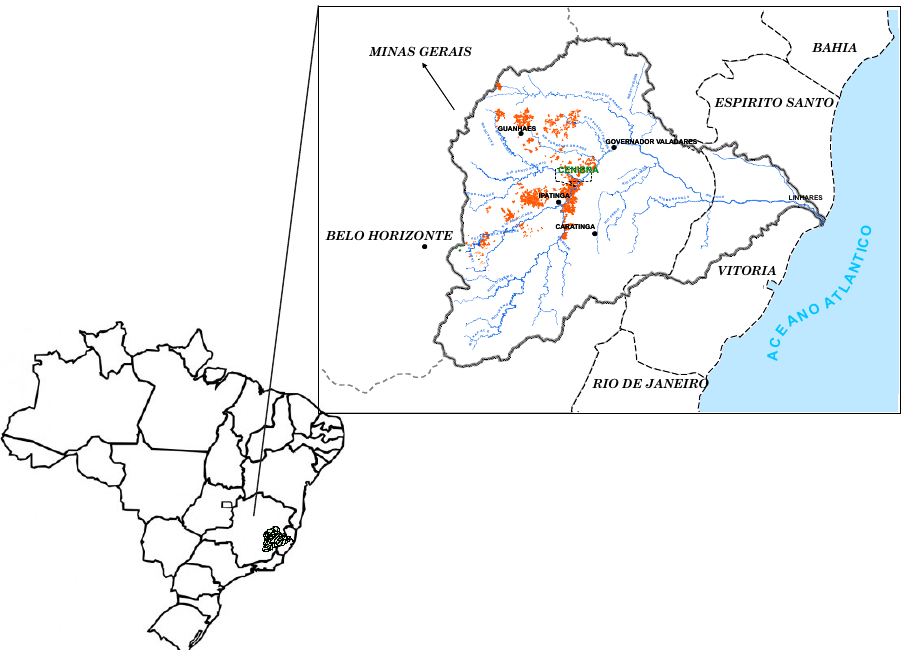
Figure 1. Localization in the region of the Bacia do Rio Doce, MG,